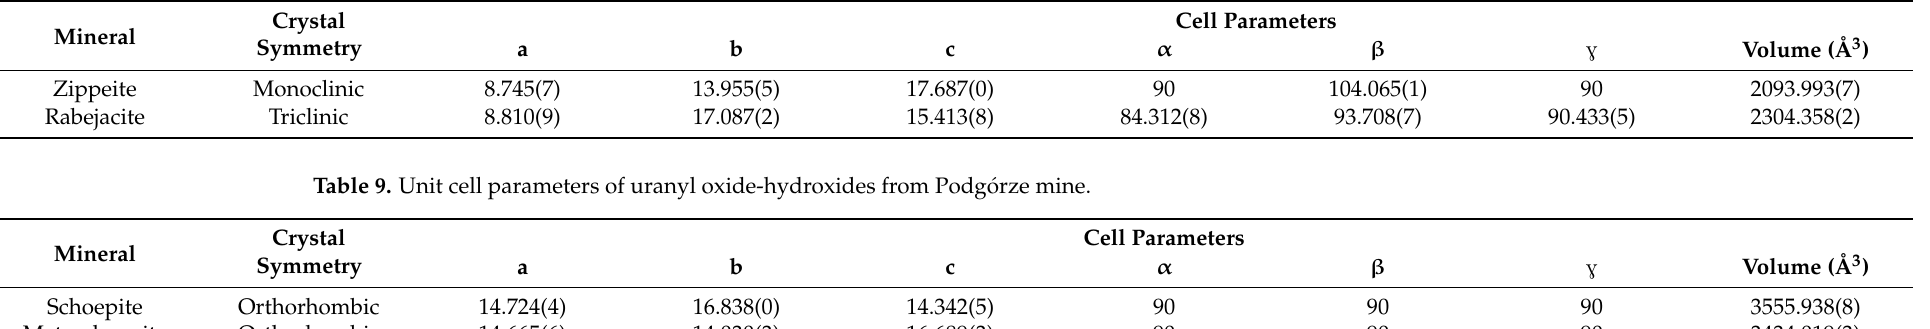
Table 8. Unit cell parameters of uranyl sulfates from Podg ó rze mine.